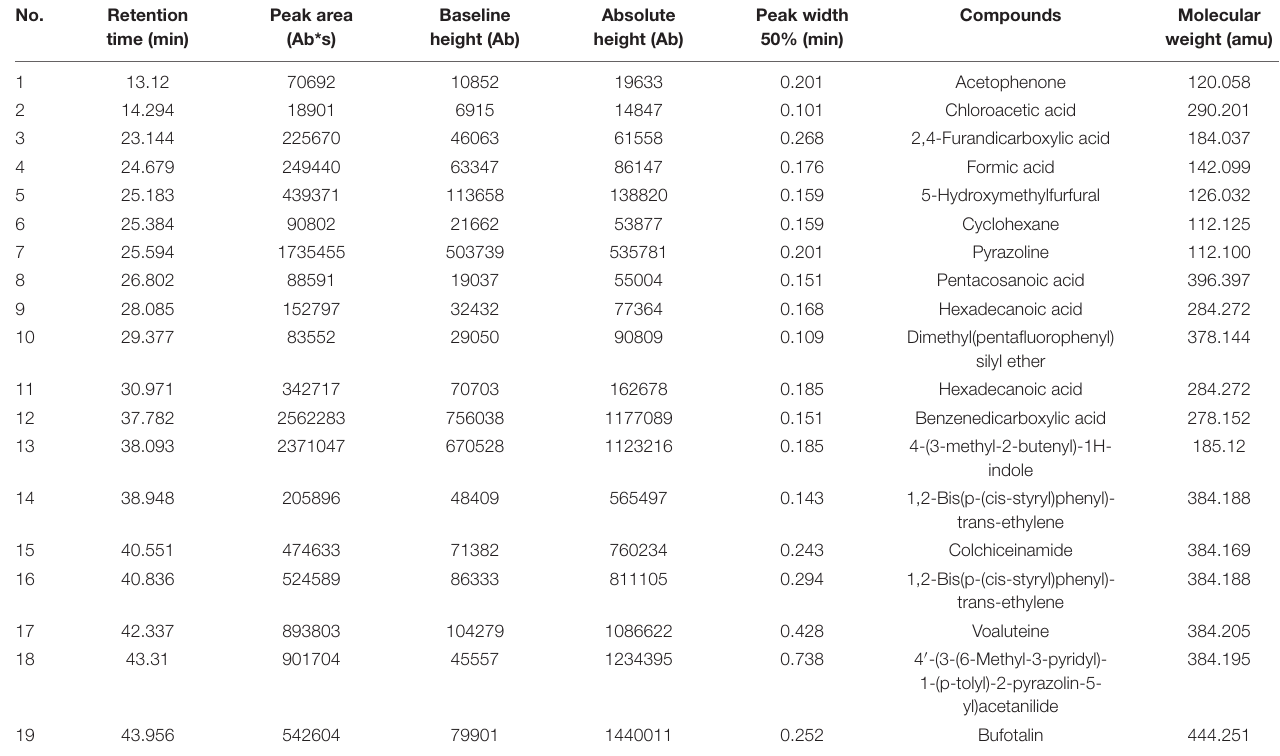
FIGURE 7 | Genome annotation of S. malaysiensis 8ZJF-21 and BGC prediction. (A) Circular map of strain 8ZJF-21 genome. From outside to center, ring 1 and ring 4 represented CDS in forward strand and reverse strand, respectively. Different colors indicate the functional category of COG. Rings 2 and 3 showed the CDS, tRNA, and rRNA in forward strand and reverse strand, respectively. Ring 5 and ring 6 show the G + C content and G + C skew, respectively. (B) COG functional annotation of S. malaysiensis 8ZJF-21 genome. (C) Genomic information and chemical structure of BGCs with 100% similarity with the known BGCs. TABLE 2 | Identification of compound components in S. malaysiensis 8ZJF-21 extract by GC-MS.